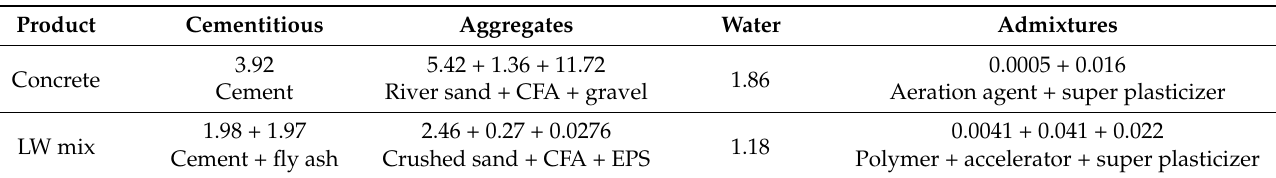
Table 1. Mix design of the CFA-based products (All values in